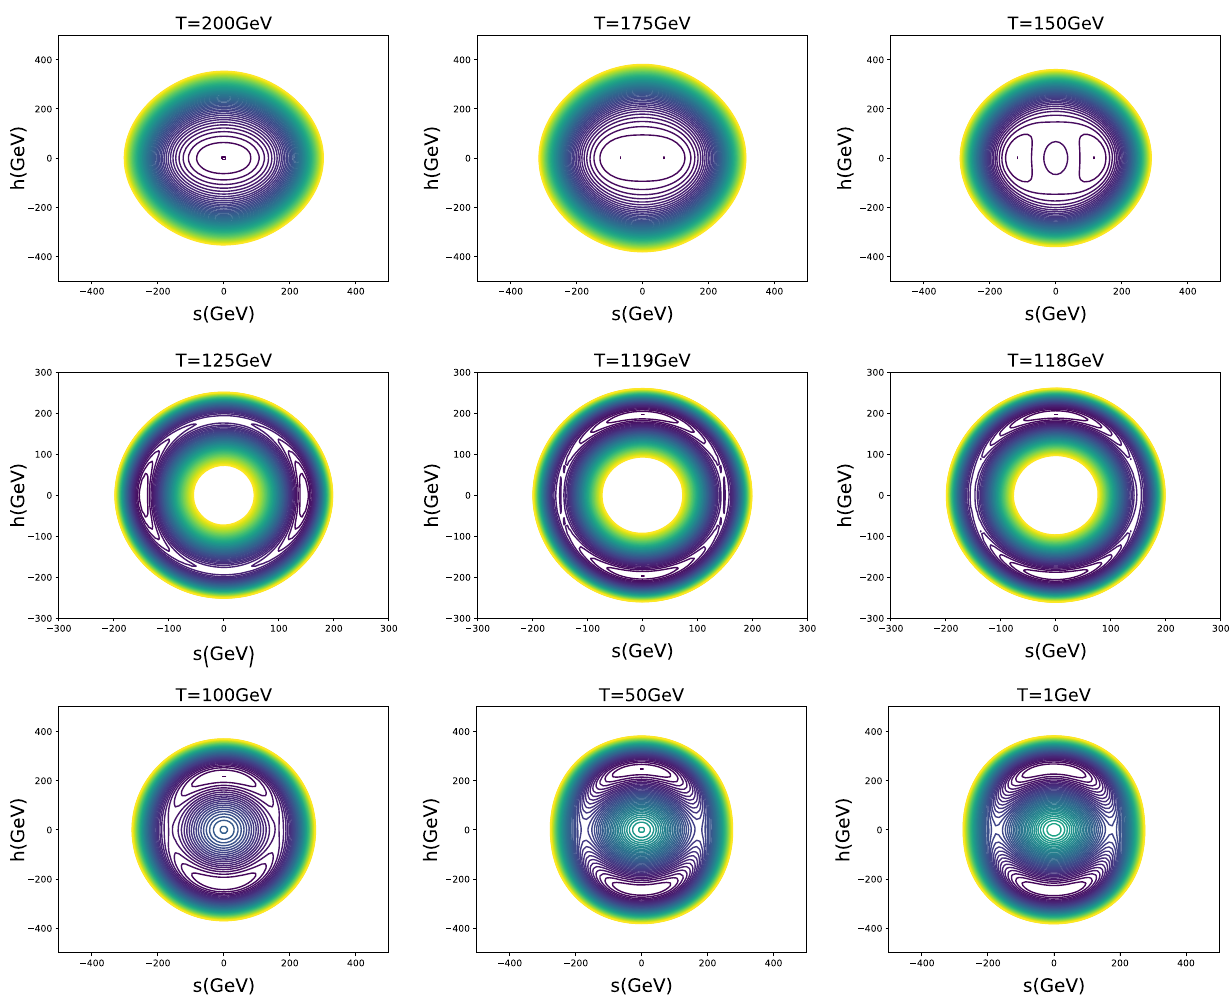
Fig. 1 An example of a higher-order s -direction PT followed by a hybrid first-order PT. This is given by the parameters v BL = 25 GeV, λ s = 0 . 35, λ = 0 . 126, λ = 0 . 388, g = 1 . 5. Here the higher-order PT happens around T (cid:4) 182 GeV, the hybrid PT happens at T (cid:4) 118 . 89 h sh